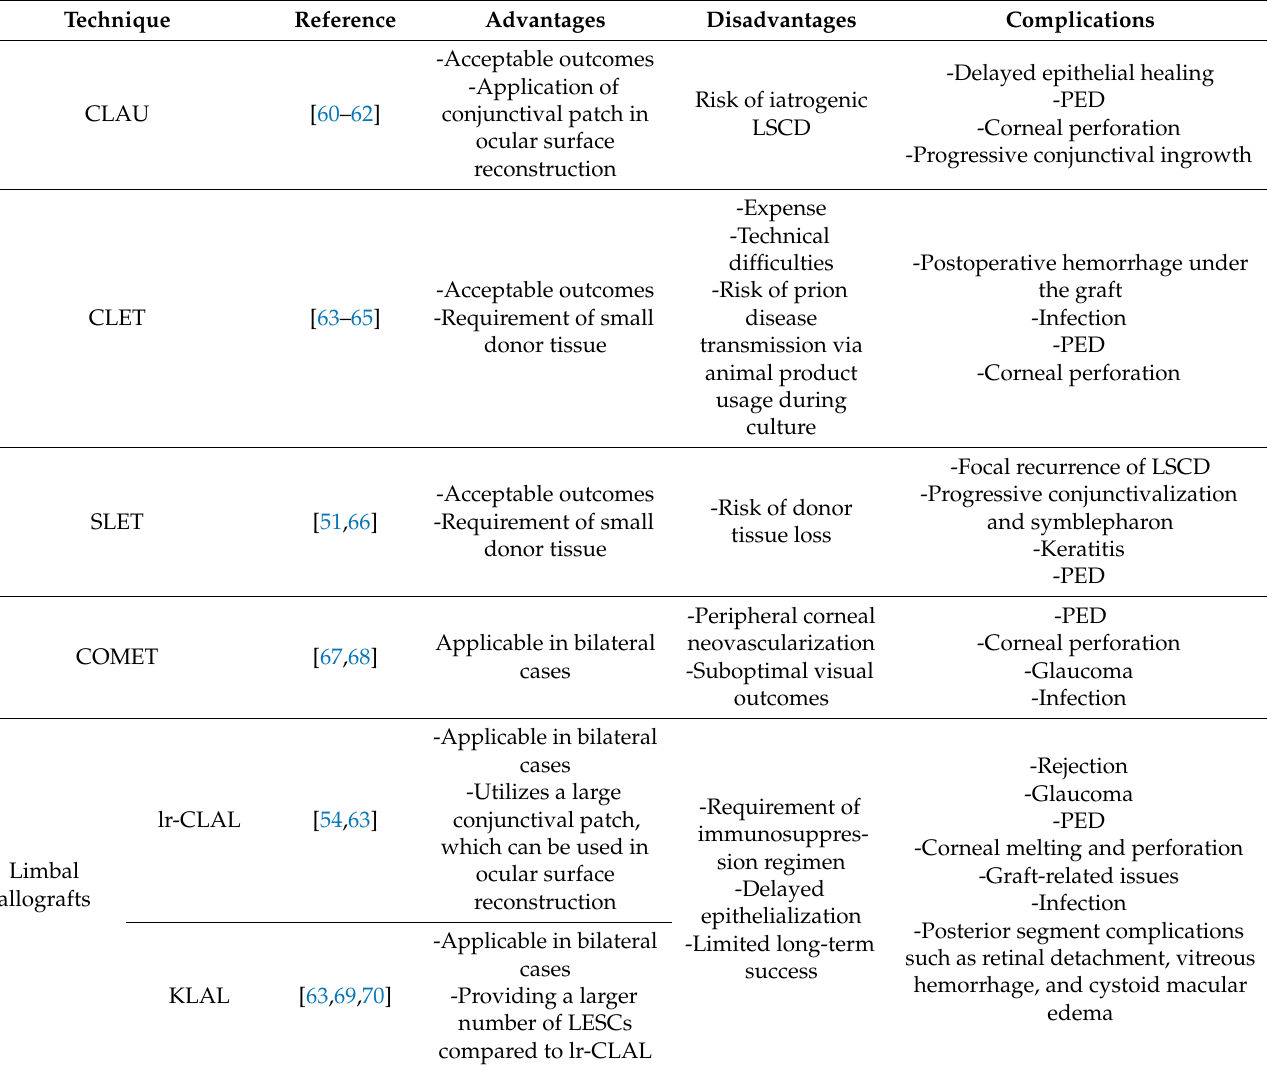
Table 1. Advantages, disadvantages, and complications of limbal stem cell transplantation techniques (CLAU: conjunctival limbal autograft, CLET: cultivated limbal epithelial transplantation, SLET: simple limbal epithelial transplantation, KLAL: kerato-limbal allograft, Ir-CLAL: living-related conjunctival limbal allograft, COMET: cultivated oral mucosal epithelial transplantation, PED: persistent epithelial defect, LSCD: limbal stem cell